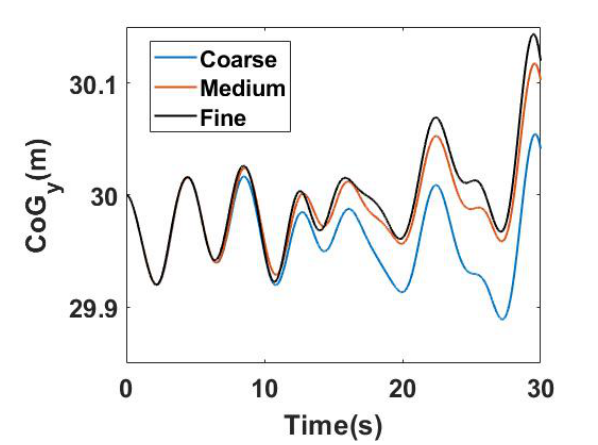
Figure 7. y-directional motion of the center of gravity of the device with different mesh resolutions.